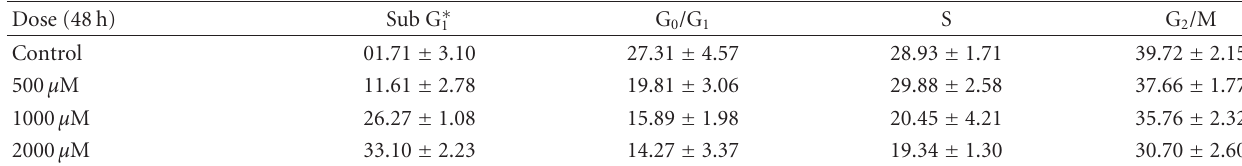
Data represents mean ± S.D; ∗ means are significant at P < 0 . 05.